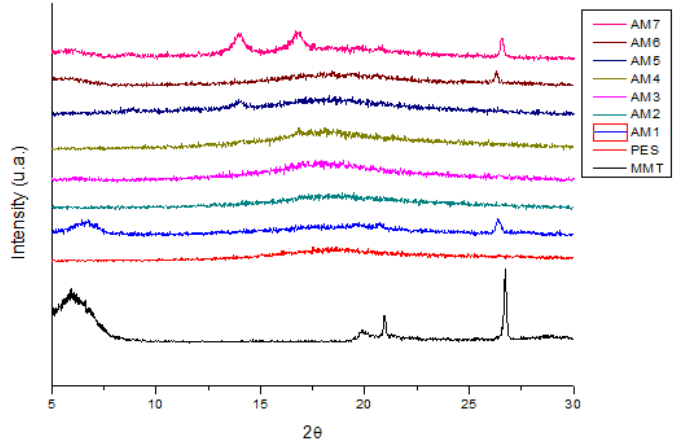
Figure 10. X-ray di ff ractograms for clay, PES, and Figure 10. X-ray diffractograms for clay, PES, and membranes.